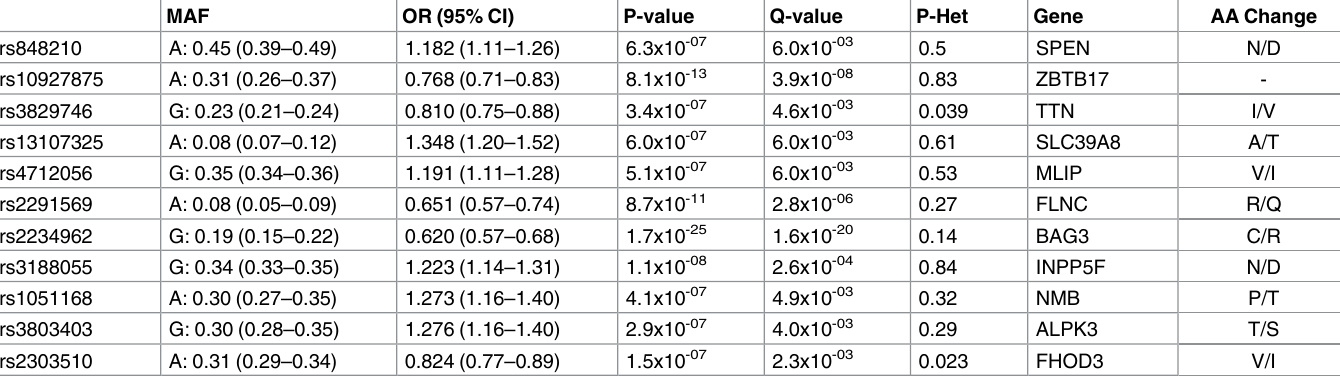
Table 1. Variants associated with